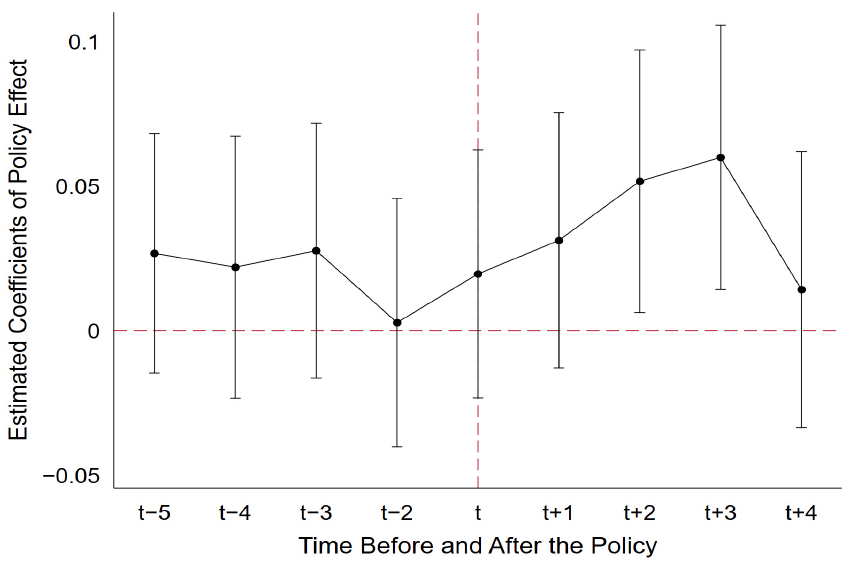
Figure 2. Parallel Trend